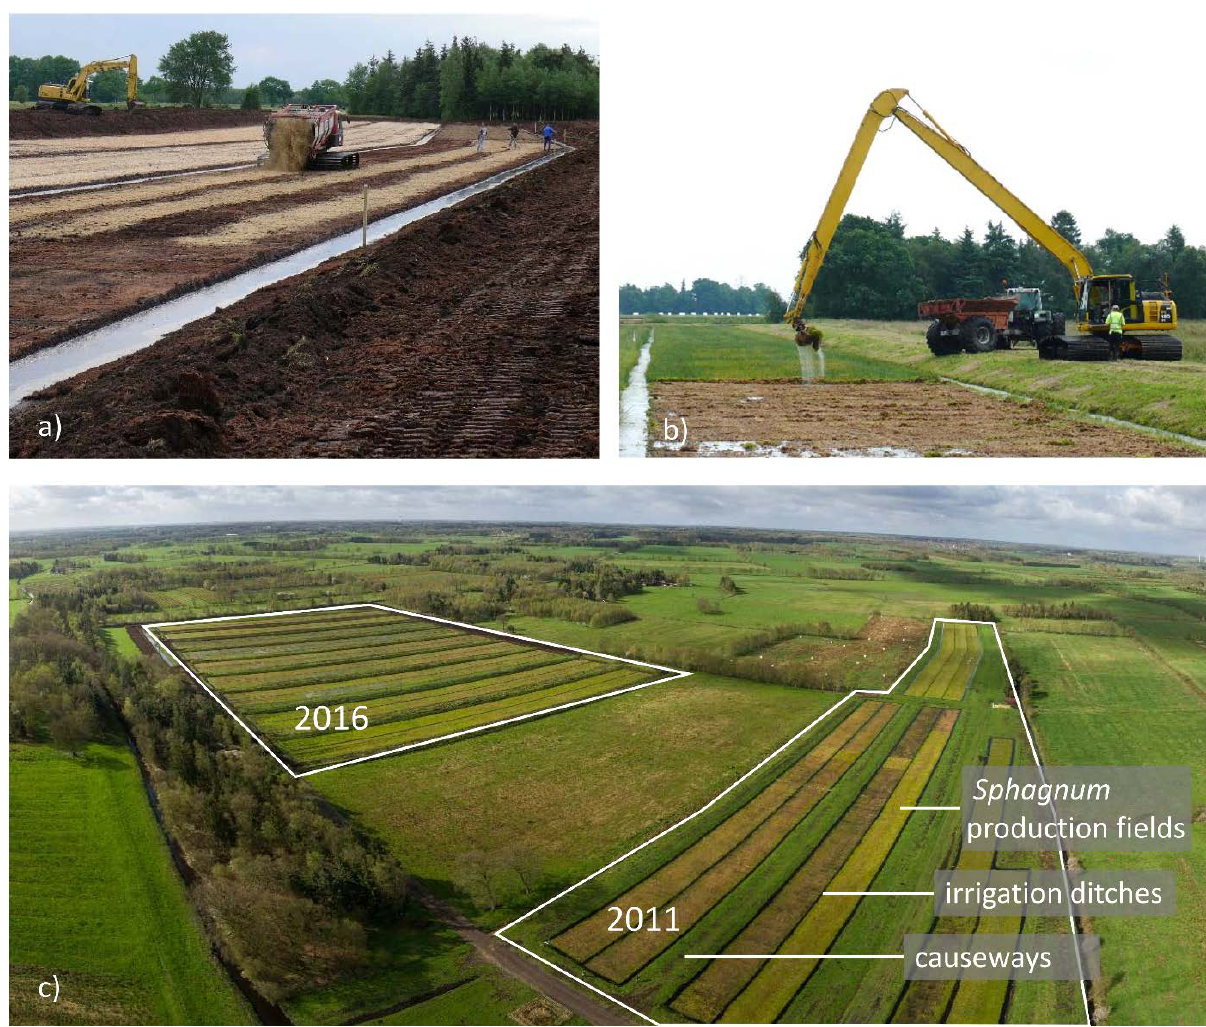
Figure 1. a) Spreading Sphagnum shoots with an adapted snow groomer during establishment of the Sphagnum farming pilot. b) First harvest using an excavator with long arm and mowing bucket. c) Aerial view of the pilot site with the five-year-old section established in 2011, the extension section established in 2016 and the surrounding drained grassland. Photos: a) and b) Sabine Wichmann, c) ASEA aerial.